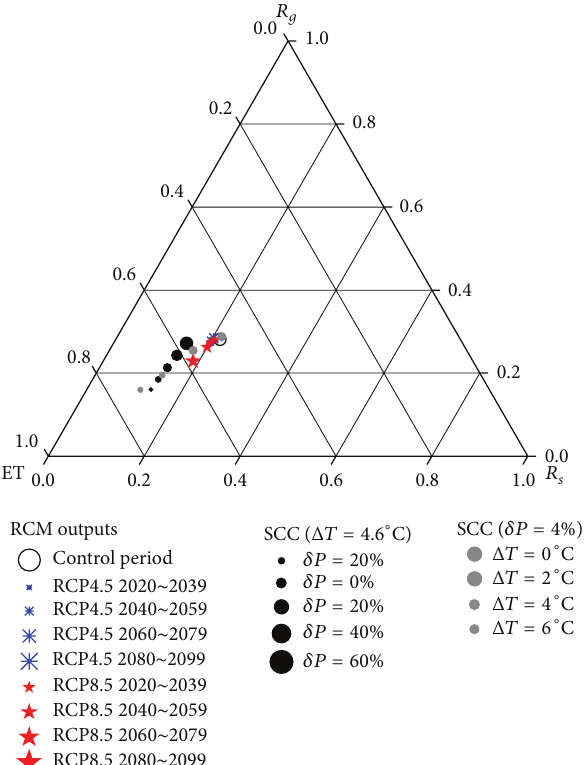
Figure 6: De Finetti diagram (ternary plot) of evapotranspiration (ET), surface runoff ( 𝑅 𝑠 ), and subsurface runoff ( 𝑅 𝑔 ) for SCC (shown as dots) and RCM outputs (shown as stars; for details of the projected changes in RCM outputs refer to Table